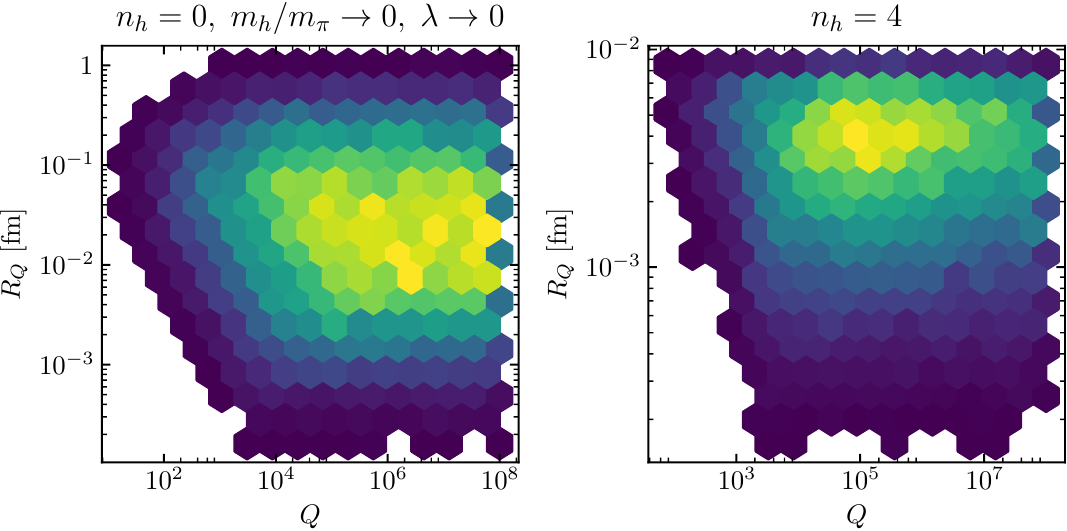
Figure 5 . The distribution of Q-ball solutions in the radius-charge plane. See caption of (cid:12)gure 3 for more